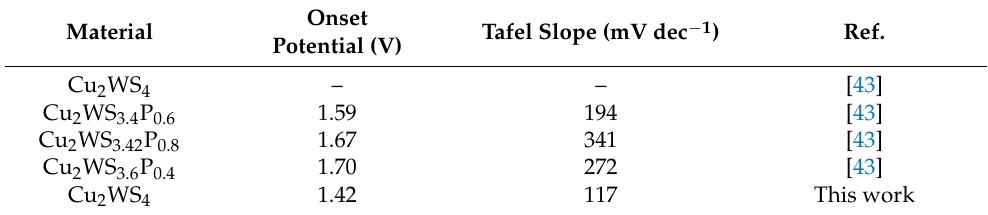
Table 2. Electrocatalytic OER performance of Cu 2 WS 4 reported herein and previously reported analogous